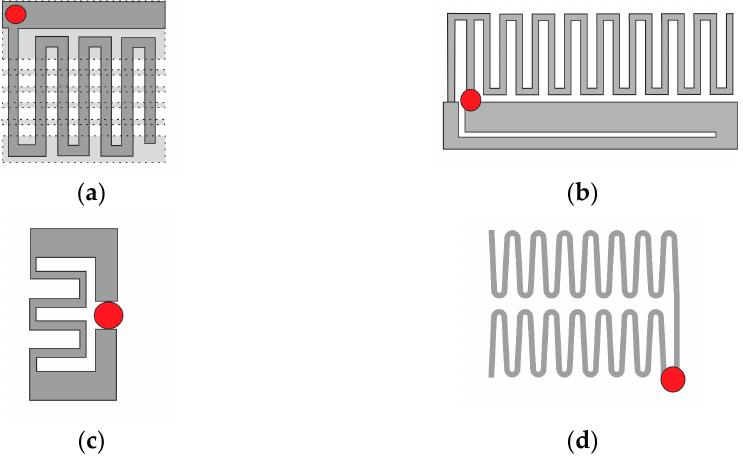
Figure 1. Radiators of antennas that operate inside human body that use meander-shaped radiator (signal source marked with red circle): ( a ) antenna presented in [14], ( b ) [19], ( c ) [21], ( d ) antenna proposed by the authors in this paper.